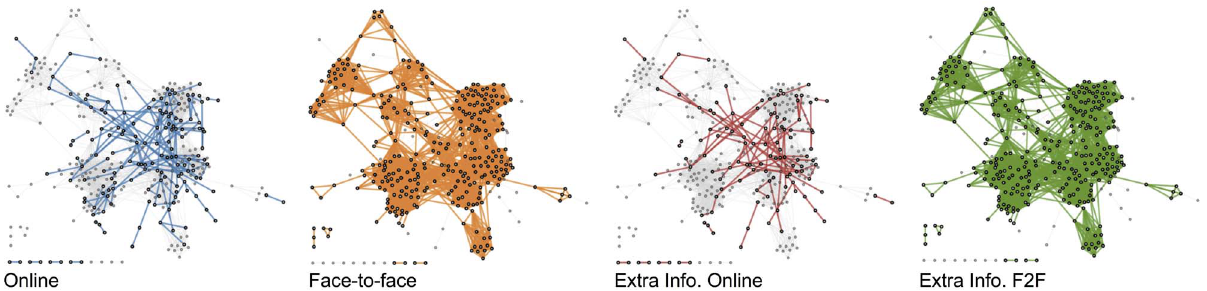
Figure 12. Face-to-face and online activity. The figure shows data from the 2013 deployment for one representative week. Online : Interactions (messages, wall posts, photos, etc.) between participants on Facebook. Face-to-Face : Only the most active edges, which account for 80 % of all traffic, are shown for clarity. Extra Info. F2F : Extra information contained in the Bluetooth data shown as the difference in the set of edges. Extra Info. Online : Additional information contained in the Facebook data.